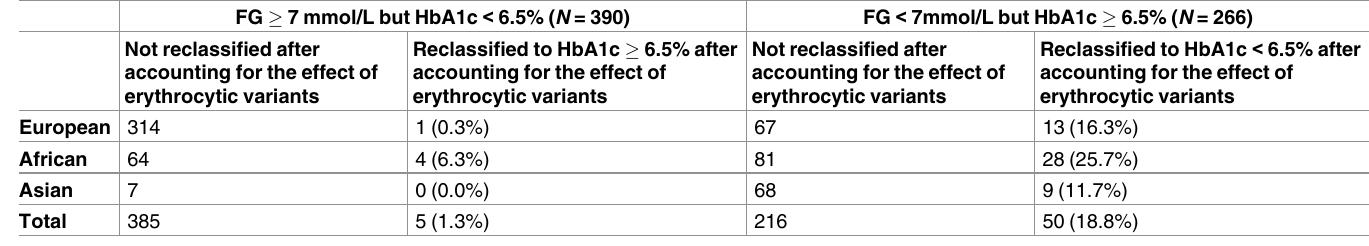
Table 2. Reclassification of individuals with discordant T2D status based on prevailing diagnostic thresholds for FG and HbA1c before and after accounting for the effect of erythrocytic variants. FG (cid:21) 7 mmol/L but HbA1c < 6.5% ( N = 390) Not reclassified after Reclassified to HbA1c (cid:21) 6.5% after accounting for the effect of accounting for the effect of erythrocytic variants erythrocytic